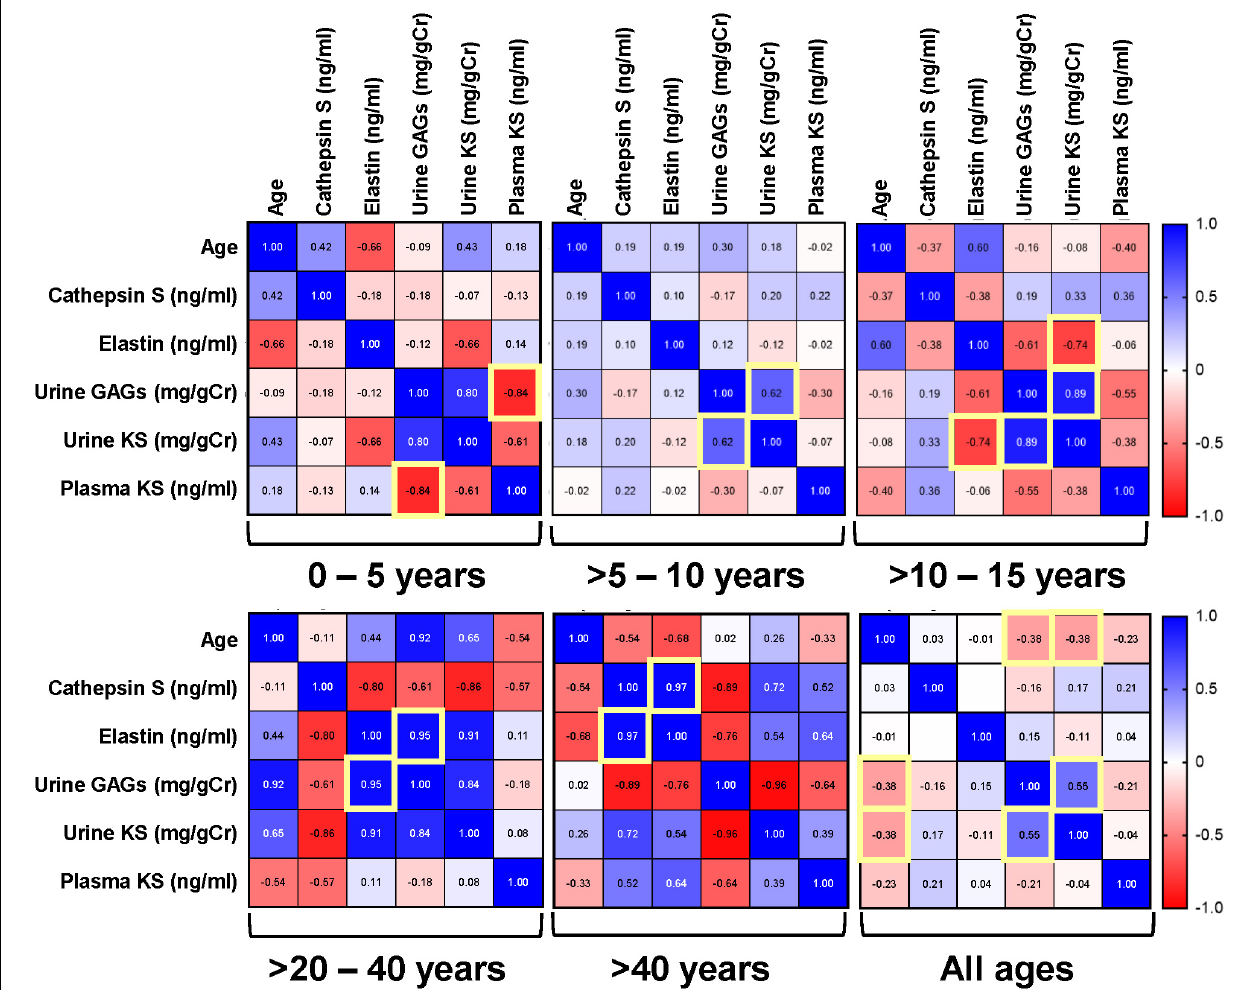
FIGURE 2 | Pairwise Pearson correlation matrix of age, keratan sulfate (KS), glycosaminoglycans (GAGs), cathepsin S and elastin in Morquio A samples stratified by age groups. Blue indicates positive correlation, and red indicates negative correlation. Darker colors are associated with stronger correlation coefficients. Yellow boxes indicate significant correlations. The term “all ages” refers to the compound group of different ages that are part of this